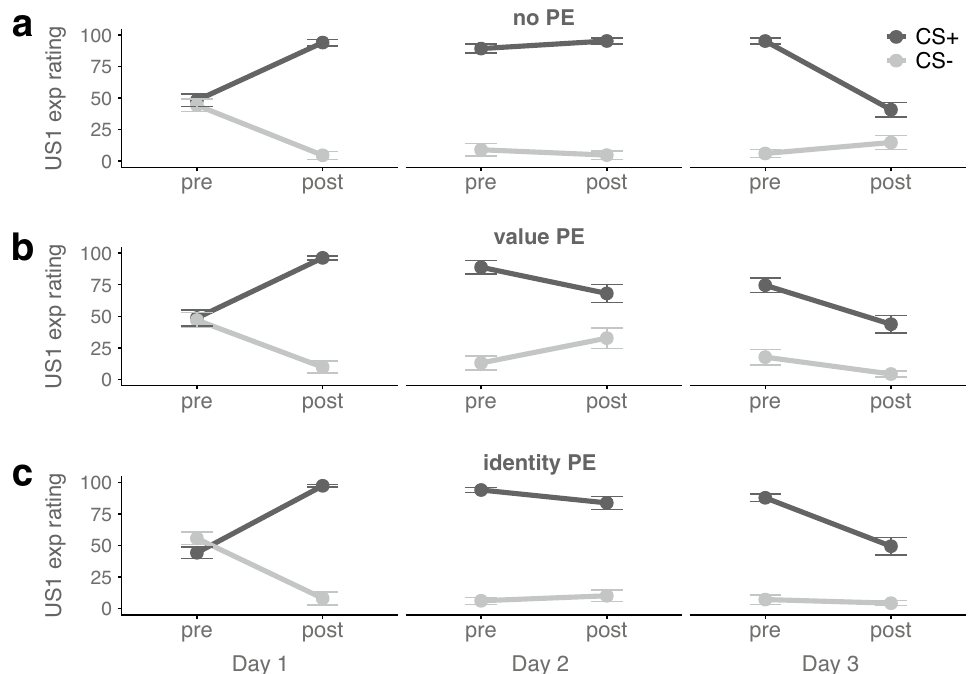
Figure 2. Pre- and post-session expectancy to receive the US1 for CS+ and CS− in ( a ) the no-PE control group, ( b ) the value-PE group for which the US1 was omitted during memory reactivation on day 2, and ( c ) the identity-PE group for which the CS+ was paired with the US2 during memory reactivation on day 2. Error bars depict standard error of the